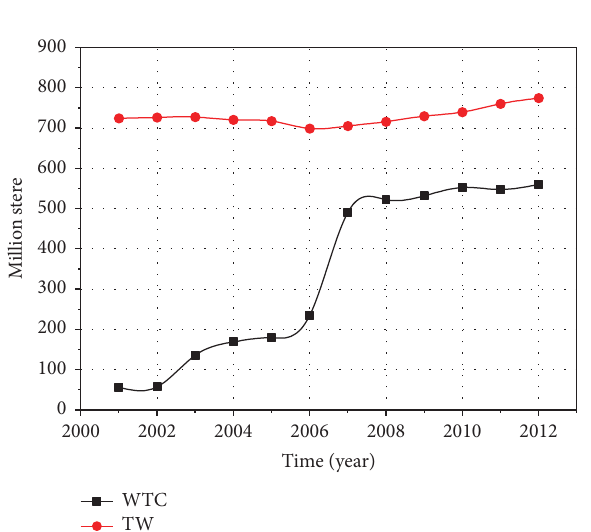
Figure 5: The component of total wastewater: domestic wastewater (DW) & industrial wastewater